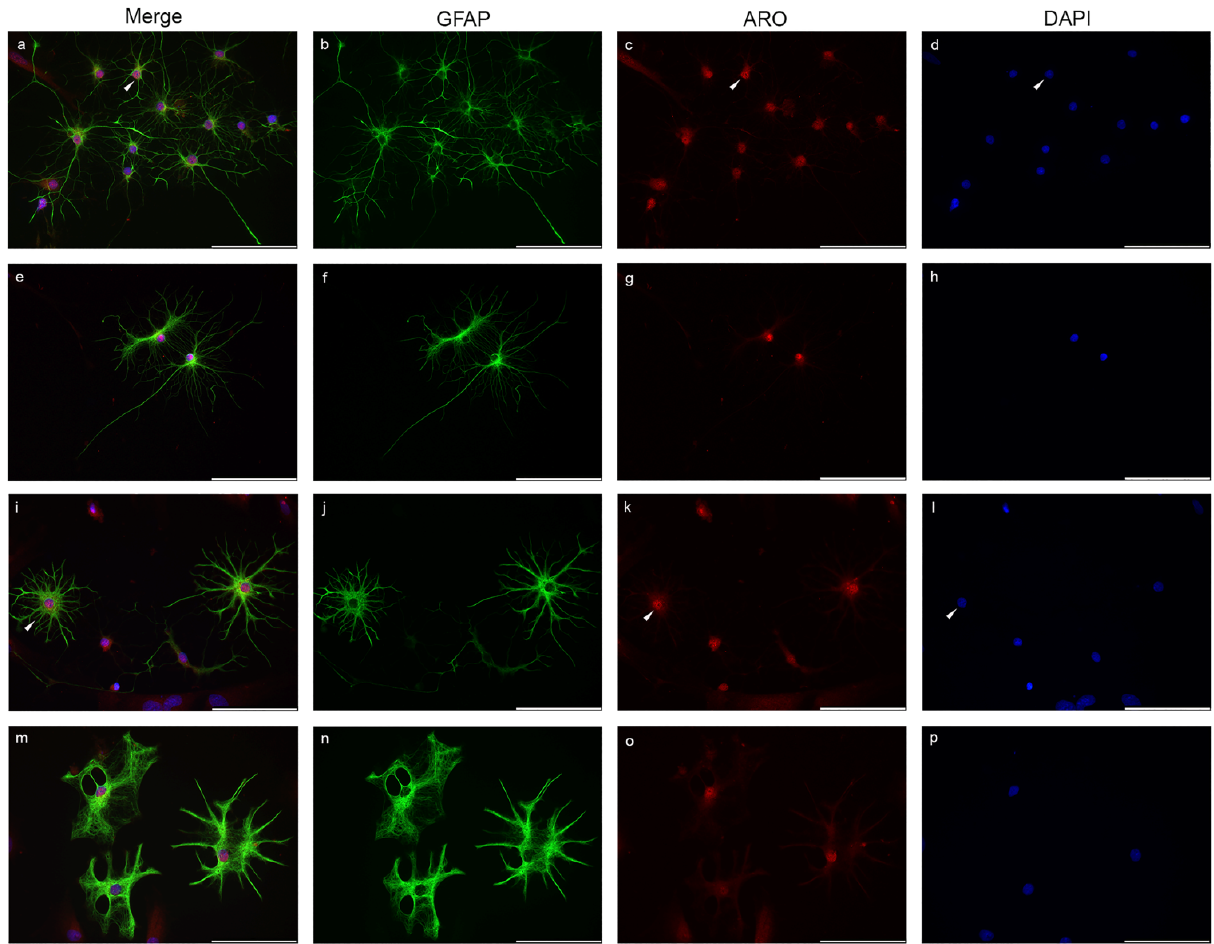
Figure 1. Aromatase (Aro) expression in astrocytes in glia-enriched subcultures. Cells were isolated from P0–P5 newborn rats. Aro (red) is strongly expressed in GFAP-positive astrocytes (green) and colocalizes with the nuclear staining (DAPI, blue). Fibrous astrocytes with small somata and long, thin unbranched processes ( a – h ) show strong nuclear Aro expression ( a , c , d , white arrowheads). Cytoplasmic Aro expression is weaker, and the long thin processes do not show Aro immunopositivity. Protoplasmic astrocytes ( i – p ) with bigger somata and short, thick and frequently branched processes also display nuclear Aro expression ( i , k , l , white arrowheads). Weak immunopositivity is detectable in the processes. The nuclear Aro signal distributes evenly or in a dotted pattern ( c , k , white arrowheads) or strongly concentrates to certain parts of the nucleus ( g ) in both astrocyte subtypes. (White arrowheads indicate a selected representative cell and its nucleus with the Aro signal). Scale bar: 100 μ m.